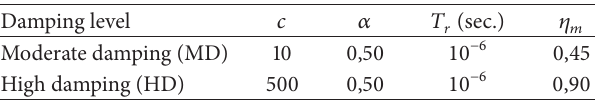
Table 2: Viscoelastic model based on fractional derivatives. Values of the damping parameters for the two considered damping